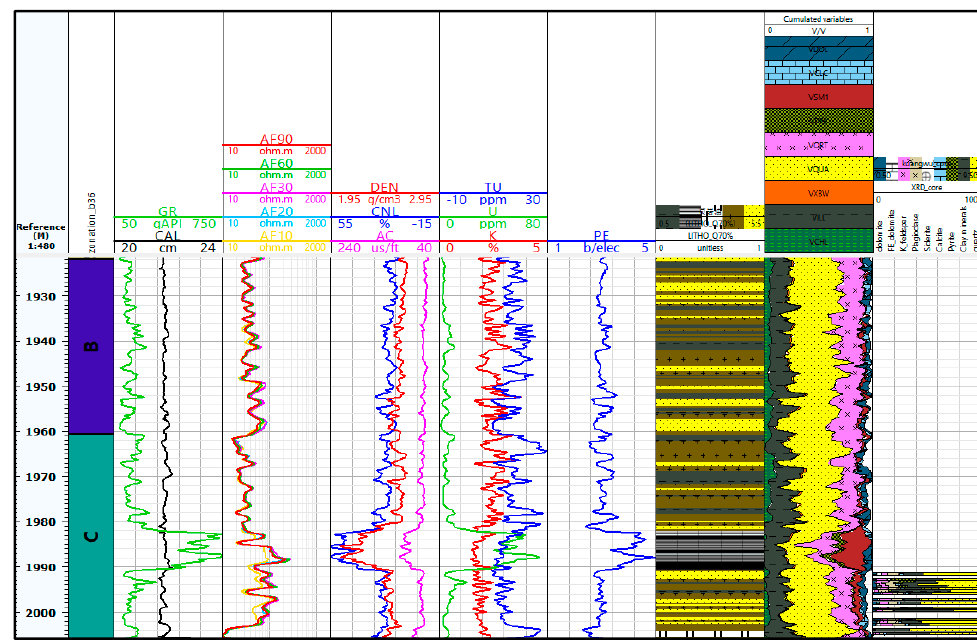
Figure 15. Log interpretation diagram of mineral content calculated by the optimized multi-mineral model in Well J3.